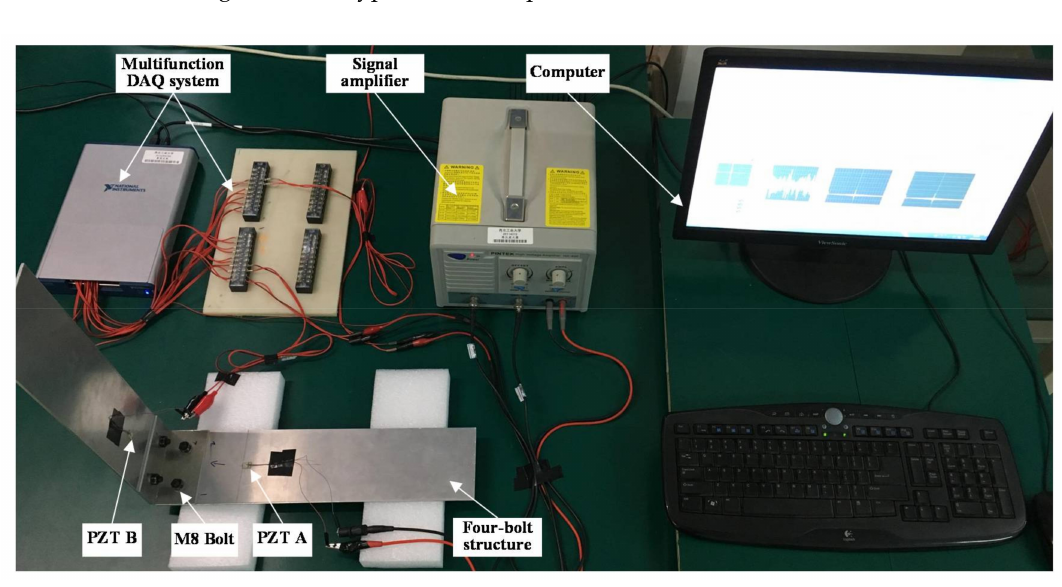
Figure 3. Experimental